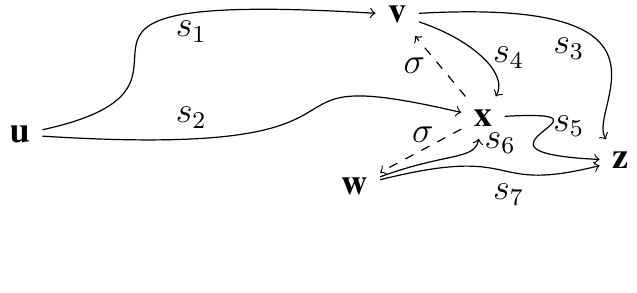
Figure 5. The production described by strings.